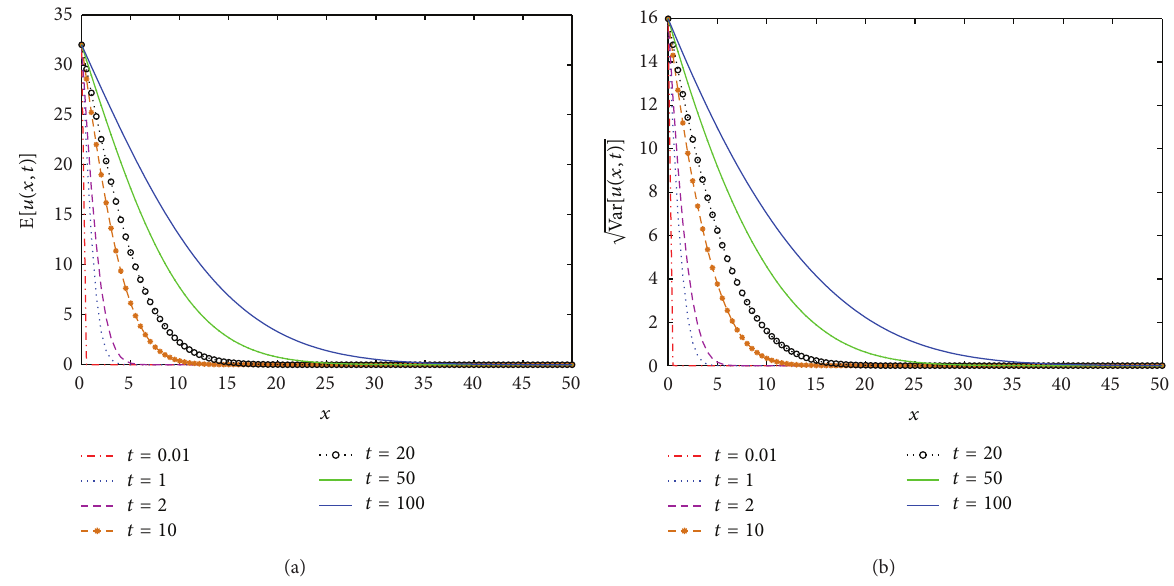
Figure 1: Approximations for the expectation E [𝑢(𝑥,𝑡)] (a), and the standard deviation √ Var [𝑢(𝑥,𝑡)] (b), on the spatial domain 0 ≤ 𝑥 ≤ 50 for some selected values in the time interval 0 < 𝑡 ≤ 100 in the context of Example